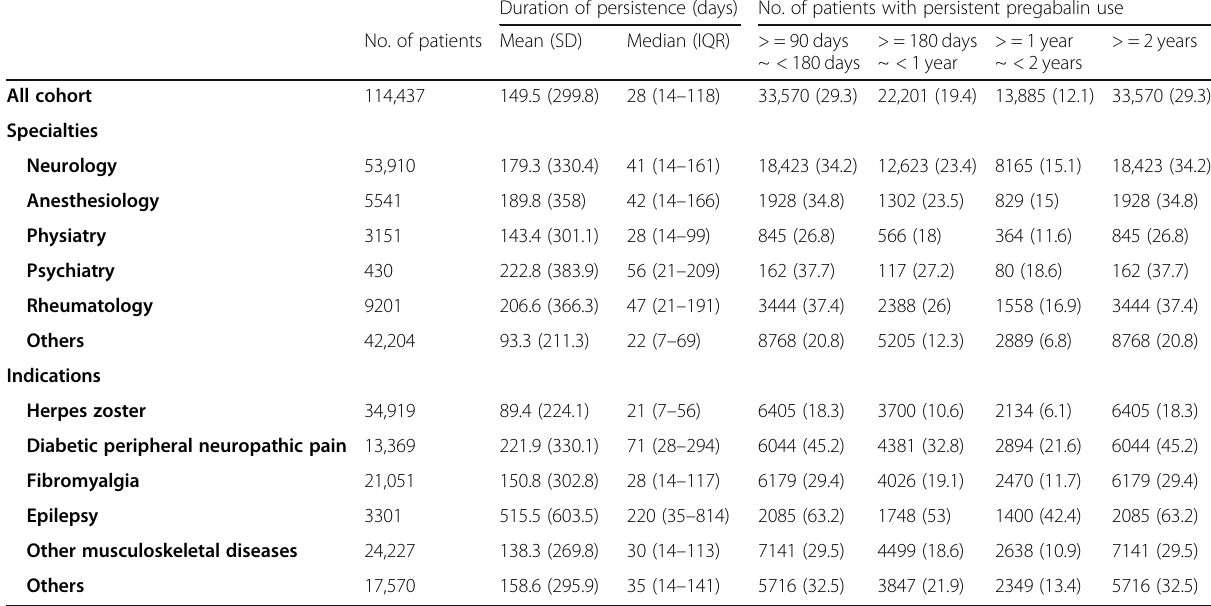
Table 2 Persistence of pregabalin during follow-up Duration of persistence (days) No. of patients with persistent pregabalin use No. of patients Mean (SD)